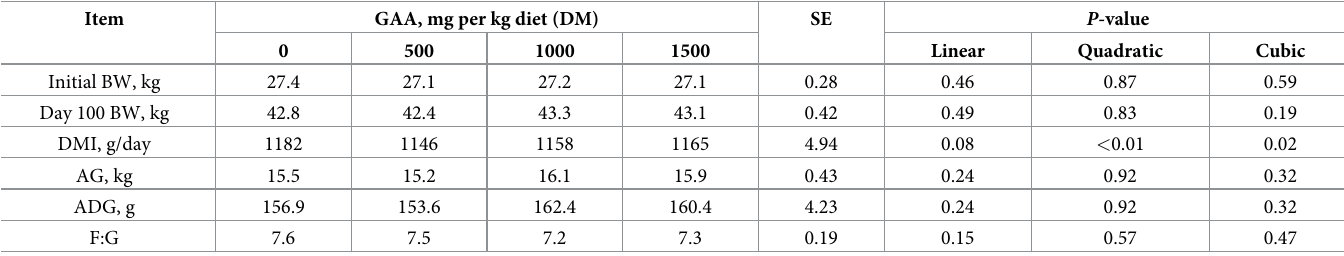
BW = body weight; DMI = dry matter intake; AG = average gain; ADG = average day gain; F:G = feed to gain ratio. The results were presented as least squares means and standard error (SE), with P < 0.05 indicating the effects are significant. The least squares means for BW, DMI, ADG, F:G in the table are the results of an analysis of covariance with initial weight as the covariate. n = 6